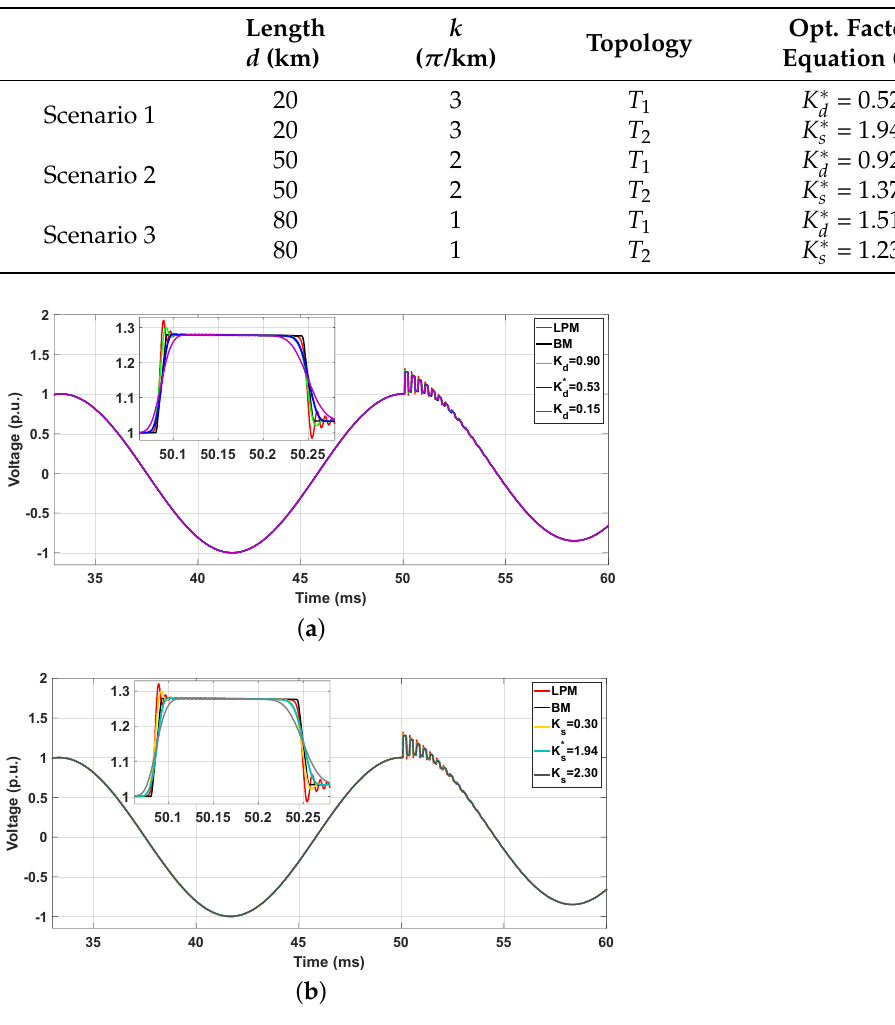
Table 3. Parameters in the three scenarios studied.